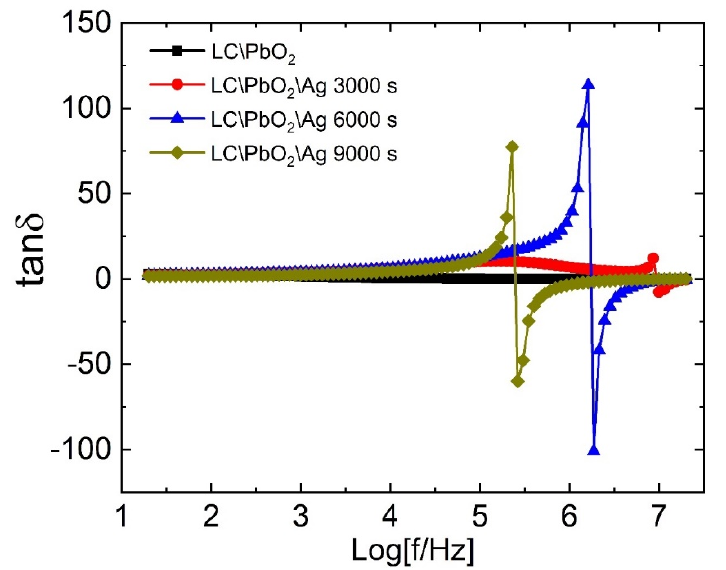
Figure 4. The dielectric loss tangent of LC\PbO 2 , LC\PbO 2 \Ag3000s, LC\PbO2\Ag6000s, and LC\PbO 2 \Ag9000s samples.